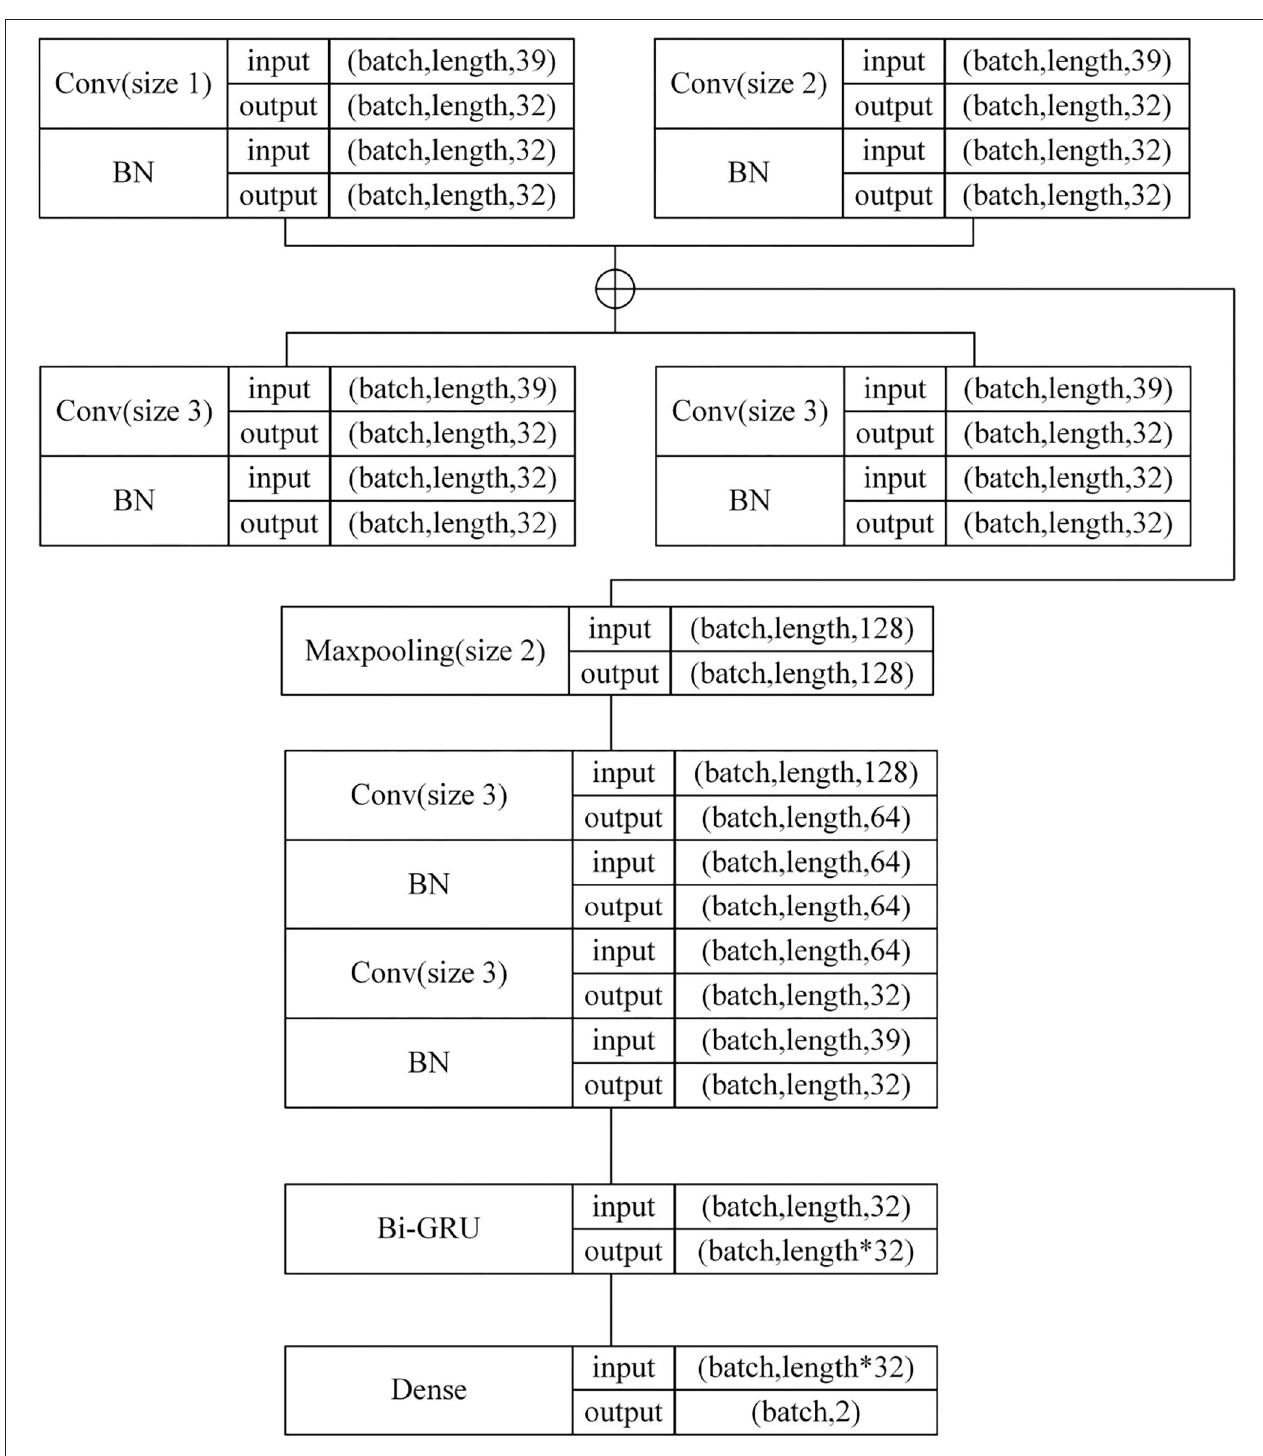
FIGURE 4 | 1D-CBBG network configuration